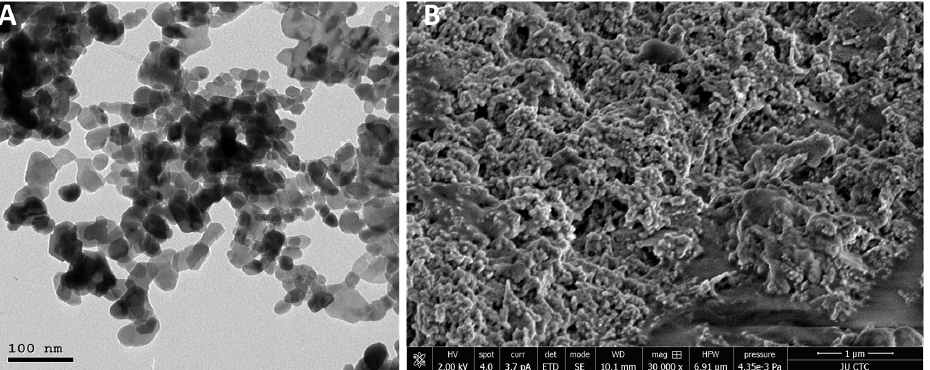
Figure 3. Representative TEM ( A ) and SEM ( B ) images indicate the formation of spherical nanopar- ticles using the green synthesis approach with a particle size between 50–60 ± 5 nm in diameter. SEM analysis further confirmed that the 3D arrangement of the generated particles was spherical with monodisperse particle distribution.